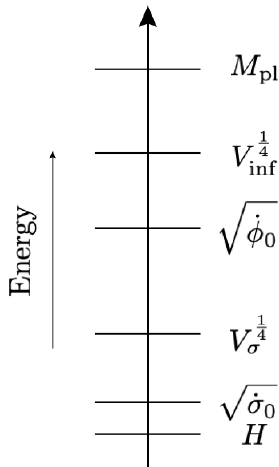
Figure 1 . Various energy scales discussed in this work. H and M pl are respectively, the in(cid:13)ationary Hubble scale and the Planck scale. V 1 = 4 scales of the in(cid:13)aton (cid:12)eld. Similarly, V 1 = 4 (cid:27) and scales of the curvaton (cid:12)eld. A sample set of values of the above scales can be obtained using the benchmark parameter point given in eq.